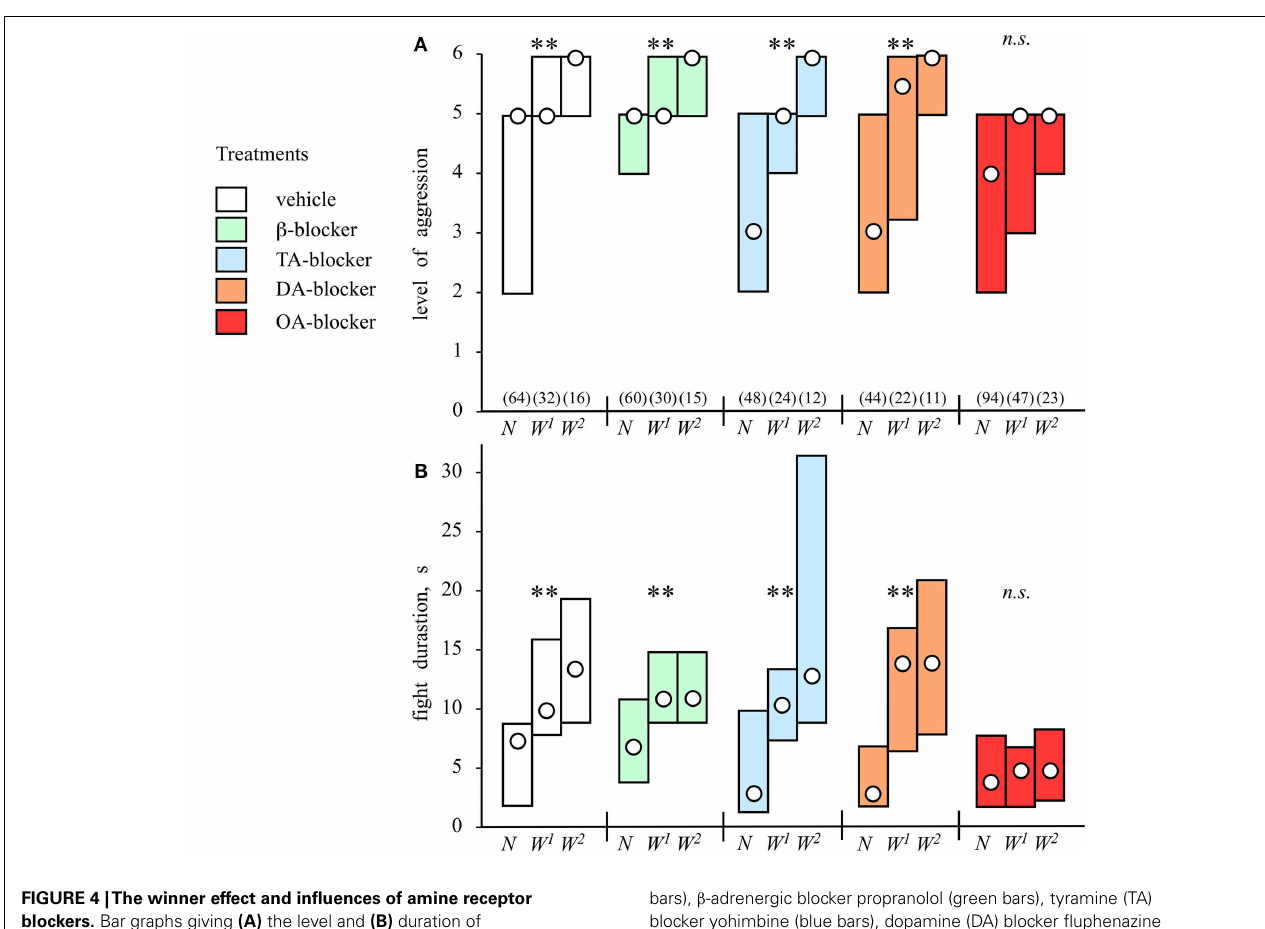
FIGURE 4 |The winner effect and influences of amine receptor blockers. Bar graphs giving (A) the level and (B) duration of aggression (median, interquartile range) for fights between pairs of weight matched male crickets that were socially inexperiences (naive, N), winners of one previous encounter (W 1 ), or winners of two encounters (W 2 ) for an inter-fight-interval of 5min. Pretreatments: before the initial fight the animals were injected, with: vehicle (white